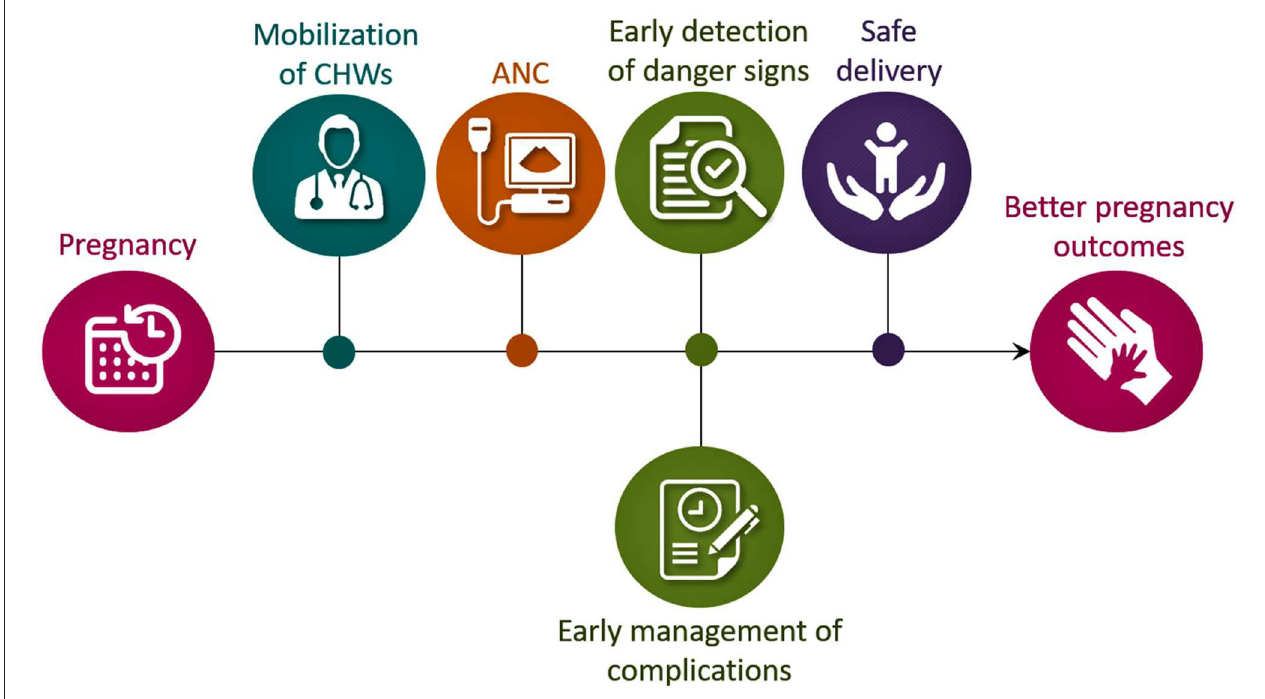
FIGURE 1 | Schematic diagram showing the importance of CHWs and ANC for better pregnancy outcomes, particularly in developing countries. CHWs, community health workers; ANC, antenatal